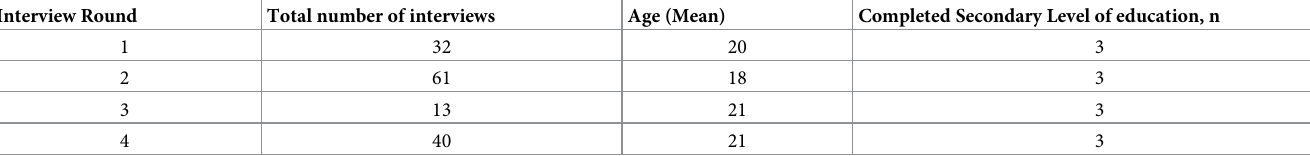
Table 1. Demographic characteristics of telephone interview respondents (n = 125